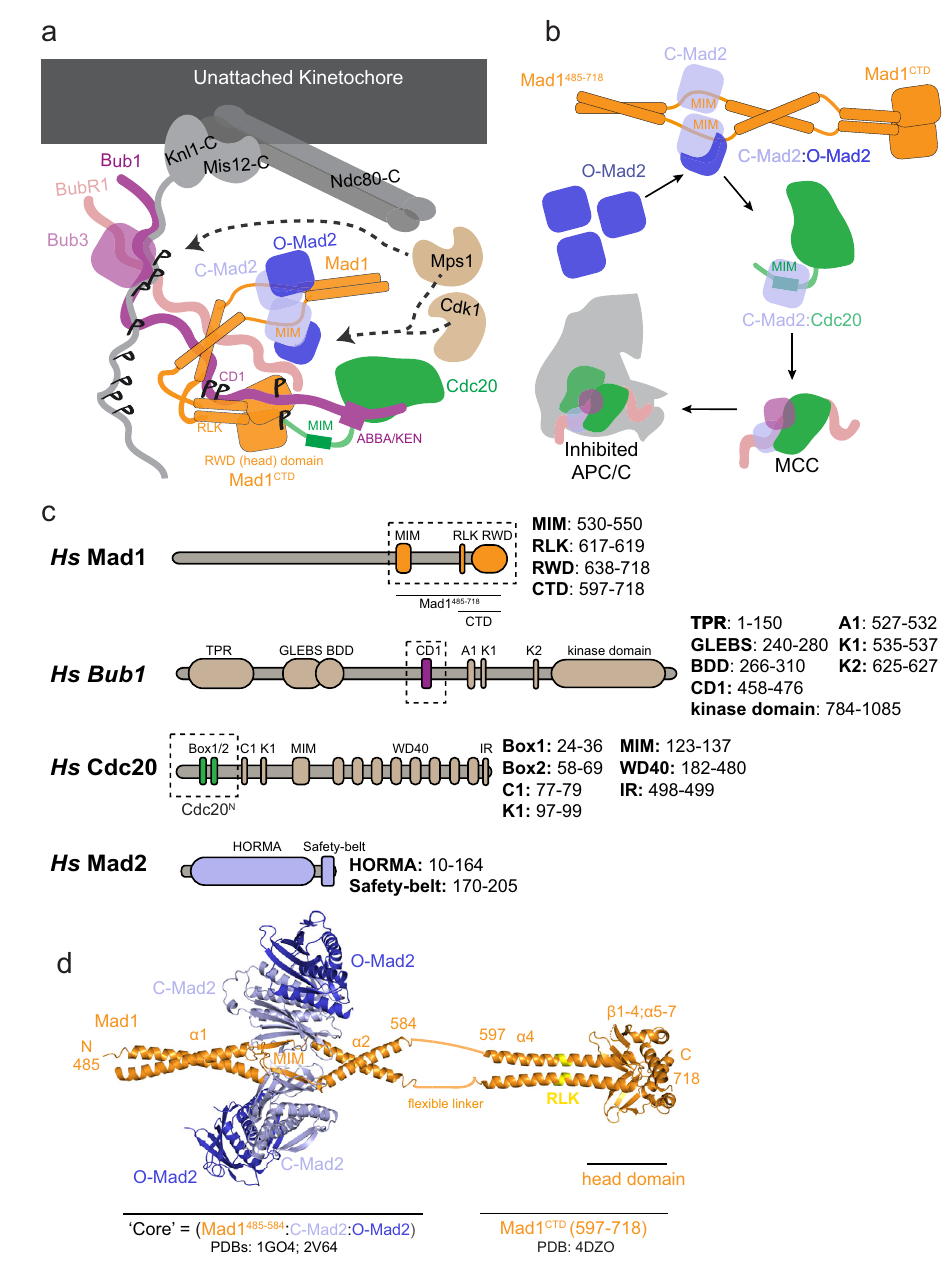
Fig.1|AssemblyoftheMCCatunattachedkinetochores.a Thecatalyticscaffold for MCC assembly onto the outer kinetochore. Phosphorylated Knl1 MELT motifs recruit the Bub3:Bub1 complex, which is sequentially phosphorylated by Cdk1 and Mps1 on the Bub1 CD1 domain. Phosphorylated Bub1 recruits the Mad1:C ‐ Mad2 complexviaitsCD1domainandO ‐ Mad2isrecruitedthroughself-dimerisationwith C-Mad2.Mad1isfurtherphosphorylatedbyMps1,whichpromotesinteractionwith Cdc20. b Thecatalyticscaffoldshownin( a )functionstobringCdc20nearO-Mad2.